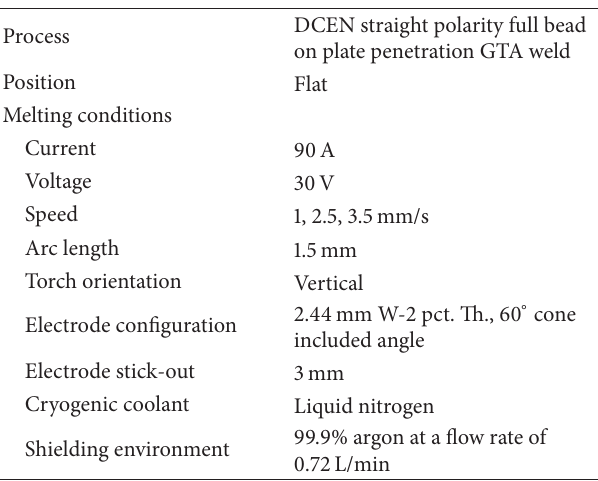
Table 2: Melting